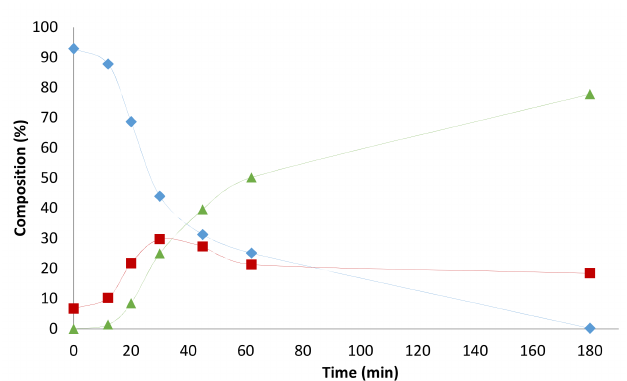
Figure A11. Composition profiles as a function of time at [ 1 ] 0 /[Rh] = 3000 with 10-undecenitrile heated at 150 ◦ C under argon prior to catalysis ( (cid:7) 1 , (cid:4) 1- int -x , (cid:78) 2 + 3 ) (conditions : 1 / 1- int -x (93.5:6.5) = 3.15 mmol, [ 1 ] 0 = 0.4 M, [ 1 ] 0 /[Rh] = 3000, [biphephos] 0 /[Rh] = 20, P = 20 bar (CO/H 2 = 1:1), toluene (8 mL), T = 120 ◦ C).